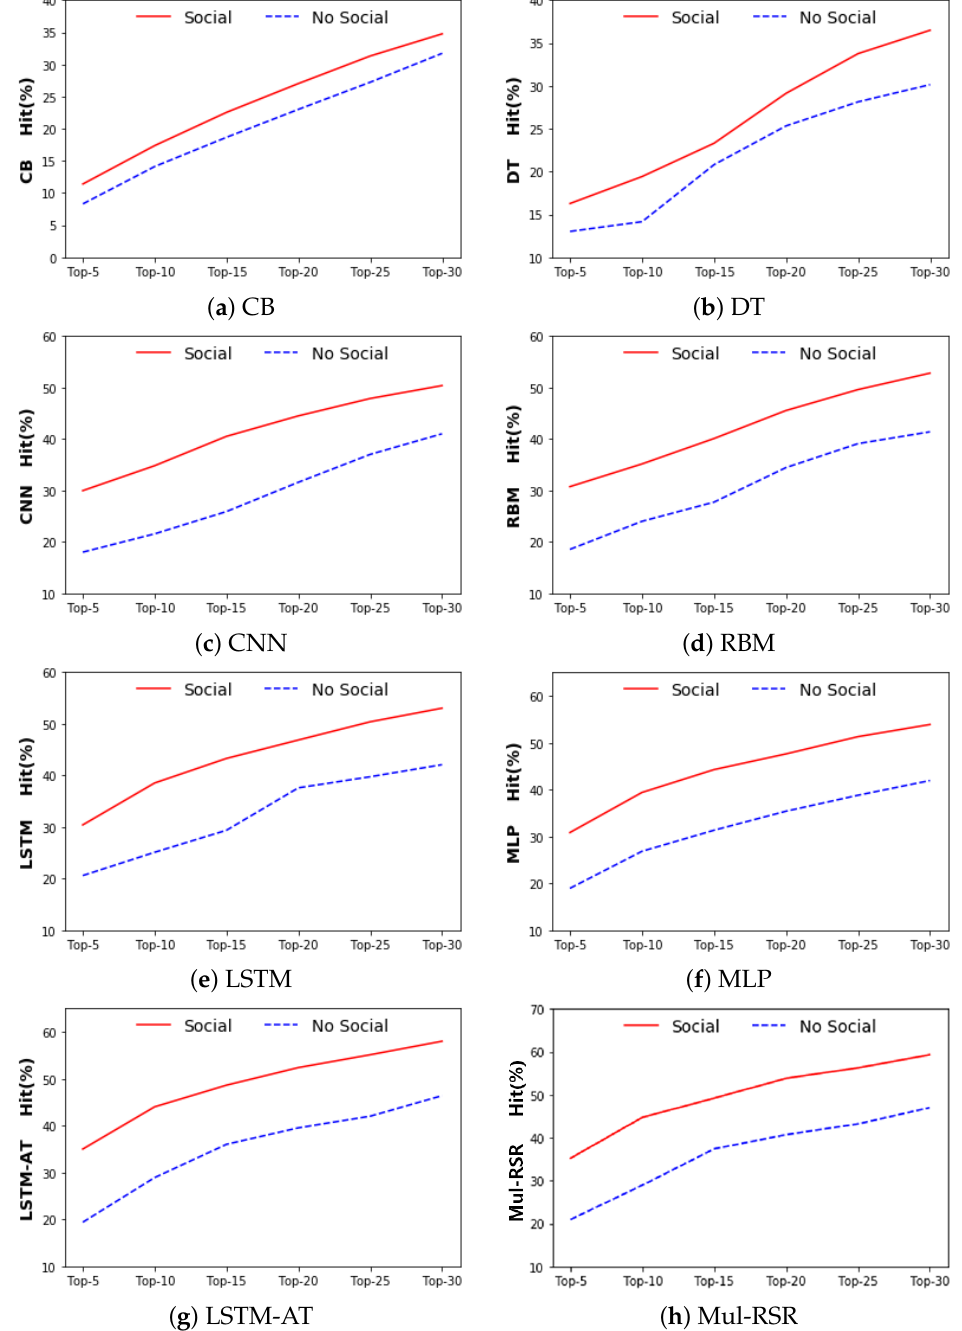
Figure 6. The effect of social relevance on the HitRate of recommendation